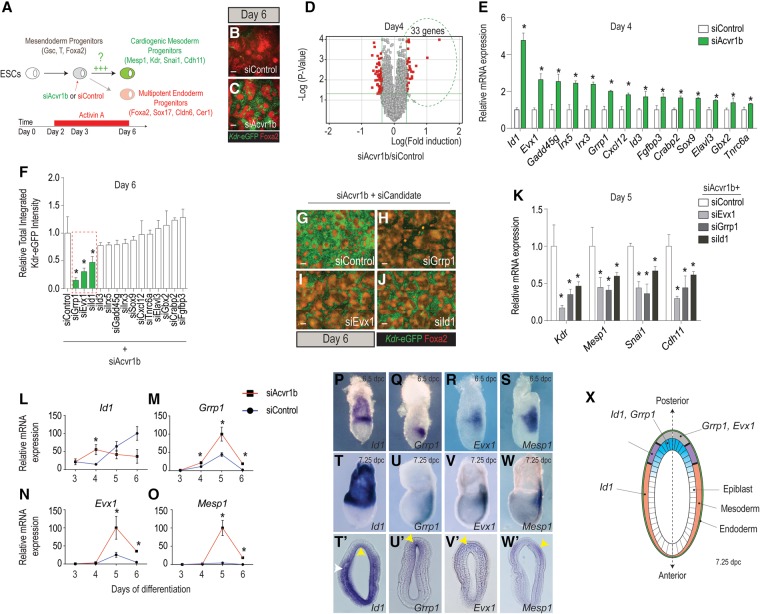
Positive regulators of CMP formation. (A) Schematic of screening strategy to identify new regulators of cardiogenic mesoderm differentiation. (B,C) Immunostaining of Kdr-eGFP (cardiogenic mesoderm) and Alexa fuor568-Foxa2 (endoderm) showing increased mesoderm differentiation in response to siAcvr1b as compared with siControl at day 6 of differentiation. Bar, 50 µm. (D) Microarray data reveal that 33 transcripts are up-regulated (P < 0.05) at day 4 in response to siAcvr1b as compared with siControl 24 h after transfection. (E) Quantitative RT–PCR (qRT–PCR) confirmation of the microarray results in D, showing that 14 genes are robustly up-regulated in response to siAcvr1b as compared with siControl. (F) siRNA screen of the 14 candidates from E to evaluate their requirement for cardiogenic mesoderm formation induced by siAcvr1b. Differentiation was quantified by induction of Kdr-eGFP reporter (total integrated intensity) (see the Materials and Methods for details). siGrrp1, siEvx1, and siId1 strongly repressed siAcvr1b-induced cardiogenic mesoderm. (G–J) Representative images of Kdr-eGFP and Alexa fluor 568-Foxa2 illustrating results presented in F. Bar, 50 µm. (K) qRT–PCR results showing that siGrrp1, siEvx1, and siId1 markedly repress cardiogenic mesoderm-specific marker (Kdr, Mesp1, Snai1, and Cdh11) expression. (L–O) Temporal expression profiles of Id1, Grrp1, Evx1, and Mesp1 in response to siAcvr1b or siControl from day 3 to day 6 of differentiation. (P–W′) Endogenous expression of Id1, Grrp1, Evx1, and Mesp1 in embryonic day 6.5 (E6.5) and E7.25 mouse embryos by in situ hybridization. (P–W) Whole-mount view. Transverse histological section of the proximal region of E7 embryos indicating Id1 (T′) expression in the gastrulating epiblast (yellow arrow) and migrating mesoderm (white arrow), Grrp1 (U′) expression in the gastrulating epiblast (yellow arrow), and Evx1 (V′) and Mesp1 (W′) expression in the primitive streak (yellow arrow). (X) Schematic representation of an E7.25 embryo transverse section illustrating the different domains of expression of the three candidates. The gastrulating epiblast (blue) indicates the domain where Id1 and Grrp1 expression overlaps. In the primitive streak region (gray), high levels of Evx1 expression are observed with decreased Grrp1 expression. As cells exit the primitive streak and migrate laterally (purple), they start to express Mesp1 along with Evx1. As mesoderm cells migrate more anteriorly (orange), they resume Id1 expression. All qRT–PCR data were normalized to β-actin mRNA levels. Quantitative data are presented as means ± SD. (*) P < 0.05. All experiments were performed at least in biological quadruplicates.